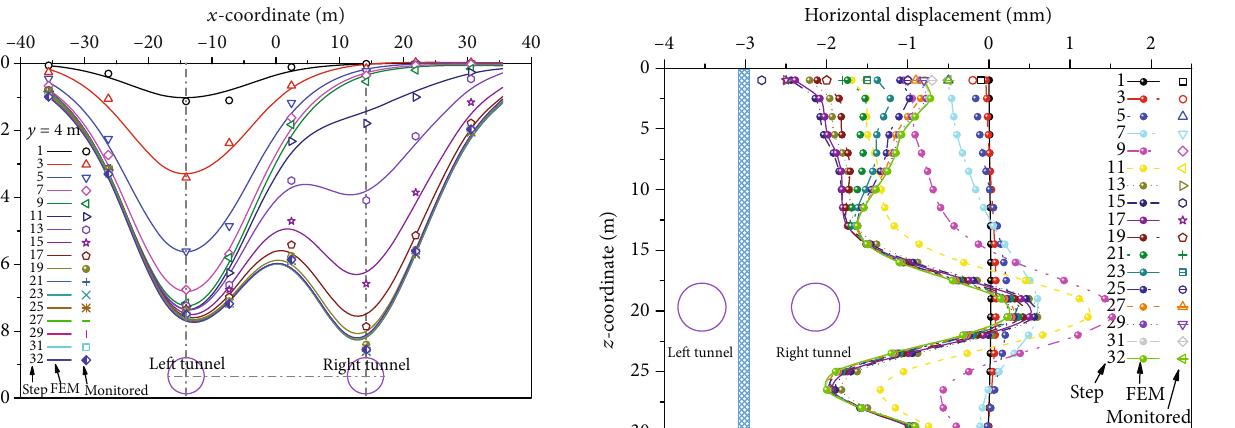
Figure 7: Ground surface settlement troughs at y = 4 m by the fi nite element method (FEM) and in situ monitoring.